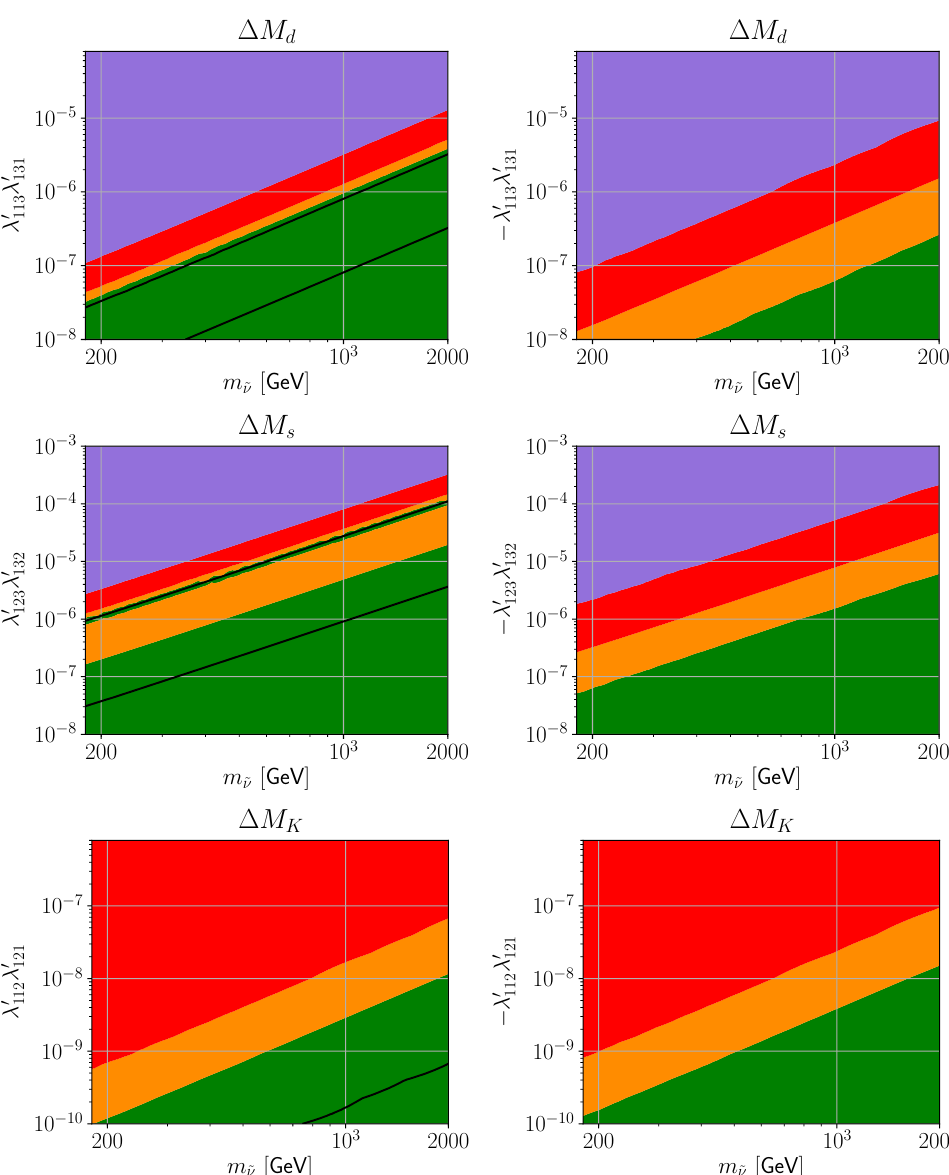
Figure 3. Constraints from the (cid:1) M ’s on scenarios with RpV-mediated (cid:13)avor violation contributing at tree-level, as a function of the sneutrino mass. The plots on the left correspond to the upper limit on positive (cid:21) 0 (cid:21) 0 ; those on the right to lower limits on negative (cid:21) 0 (cid:21) 0 combinations. The (cid:1) (cid:1) green, orange, red and purple colors represent regions within [0 ; 1 (cid:27) ], [1 (cid:27); 2 (cid:27) ], [2 (cid:27); 3 (cid:27) ] and > 3 (cid:27) bounds, respectively. The experimental central value is exactly recovered on the black lines. For these plots, the parameter set of the scenario SM-like of table 1 has been employed.